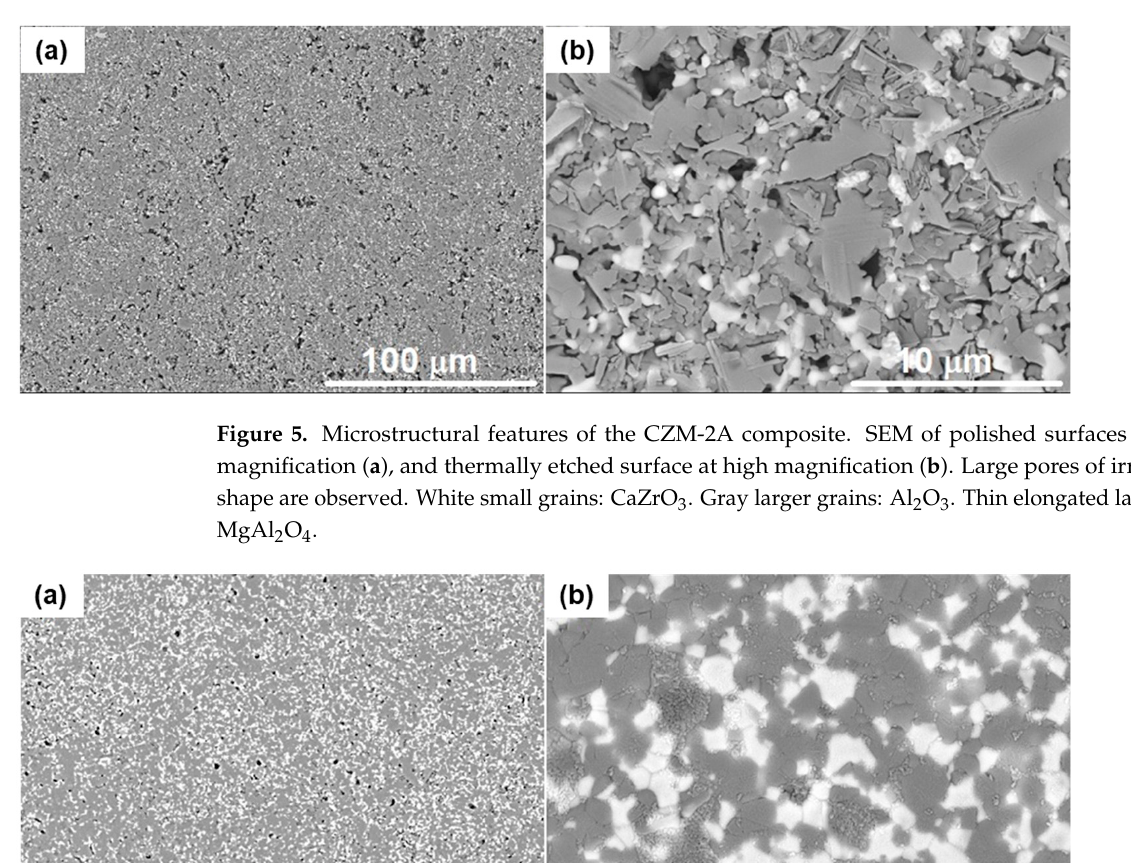
Figure 4. Microstructural features of the CZM material. SEM of polished surfaces at low magnification ( a ), and thermally etched surface at high magnification ( b ). Dark grains: MgO. Small and medium gray faceted grains: CaZrO 3 .